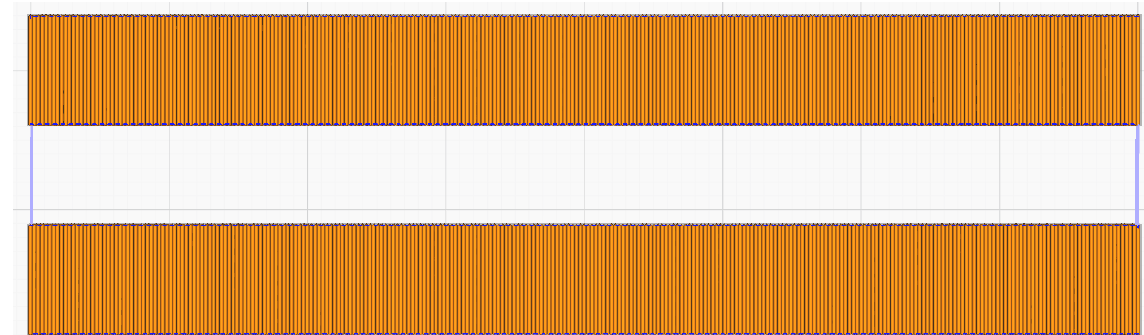
Figure 14. The diagonal travel path of the print head across a 90° orientated specimen, displayed in light blue.